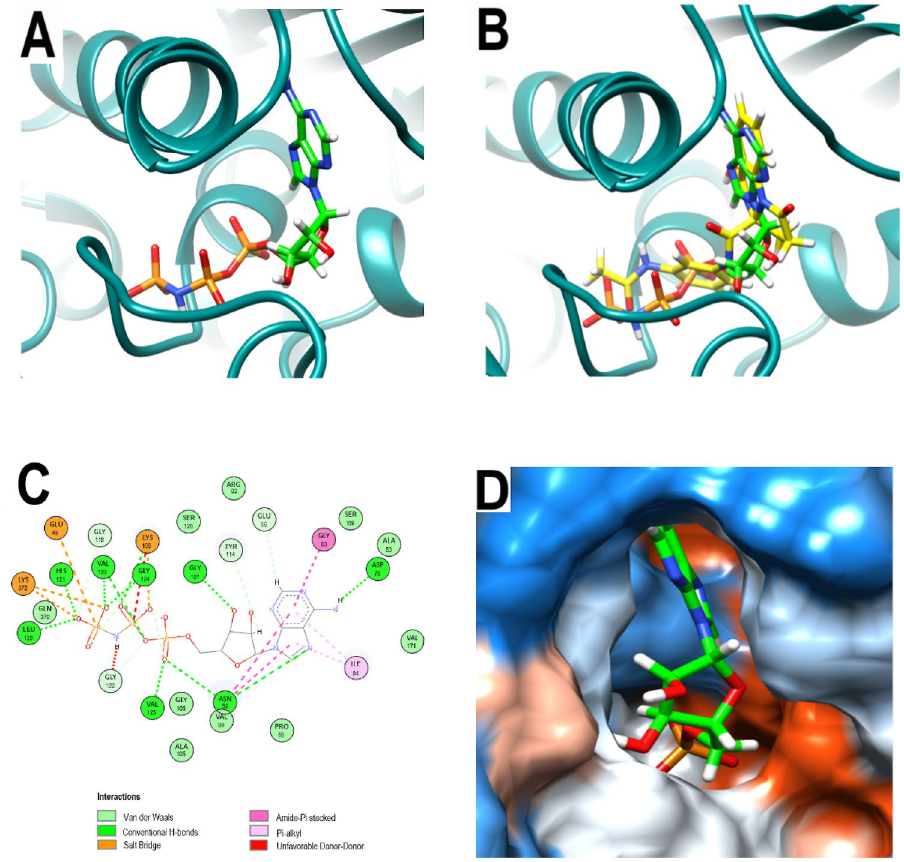
Figure 2. Analysis of the crystallographic pose of ANP. ( A ) 3D representation of the 3ZKB-ANP complex. ( B ) 3D representation of 3ZKBL-ANP-complex superimposed with PQd (yellow backbone). ( C ) 2D interaction diagram of 3ZKBL-ANP complex. ( D ) Hydrophobic surface representation of 3ZKBL complexed with ANP